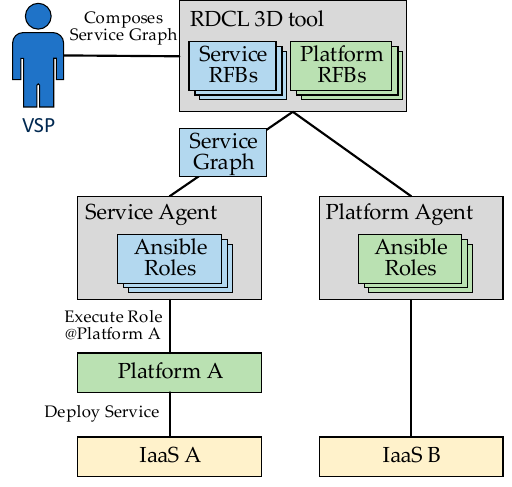
Figure 3. Overview of the RDCL 3D tool.